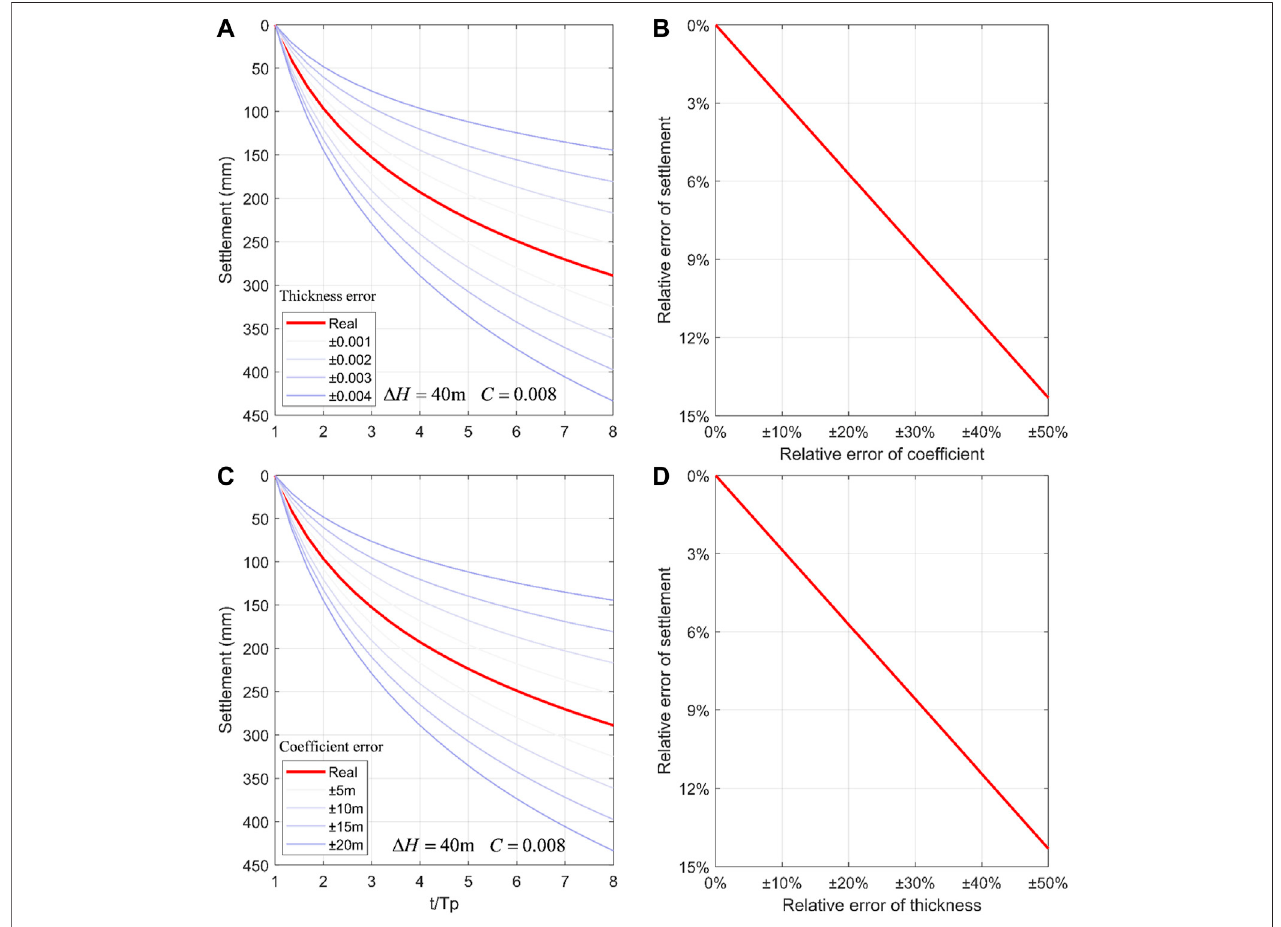
FIGURE 10 | (A,C) : Examples of the in fl uence of thickness errors and coef fi cient errors on the predicted settlement, respectively; (B,D) : Relationship of the predicted settlement relative errors with thickness and coef fi cient relative errors, respectively.